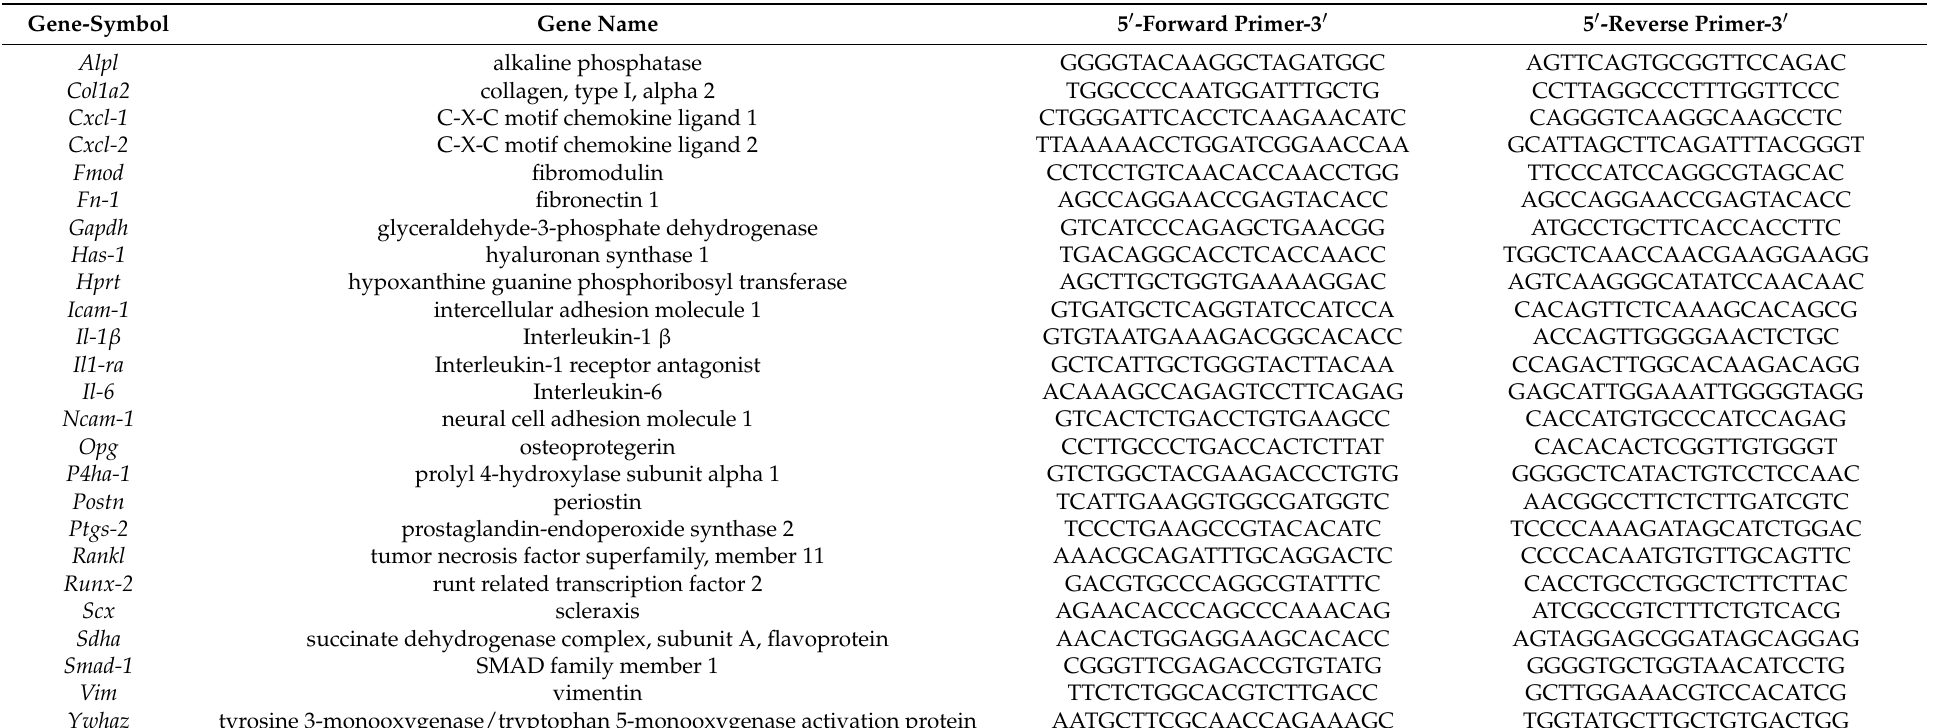
Table 1. Primer sequences for reference and target genes used in RT-qPCR and semiquantitative